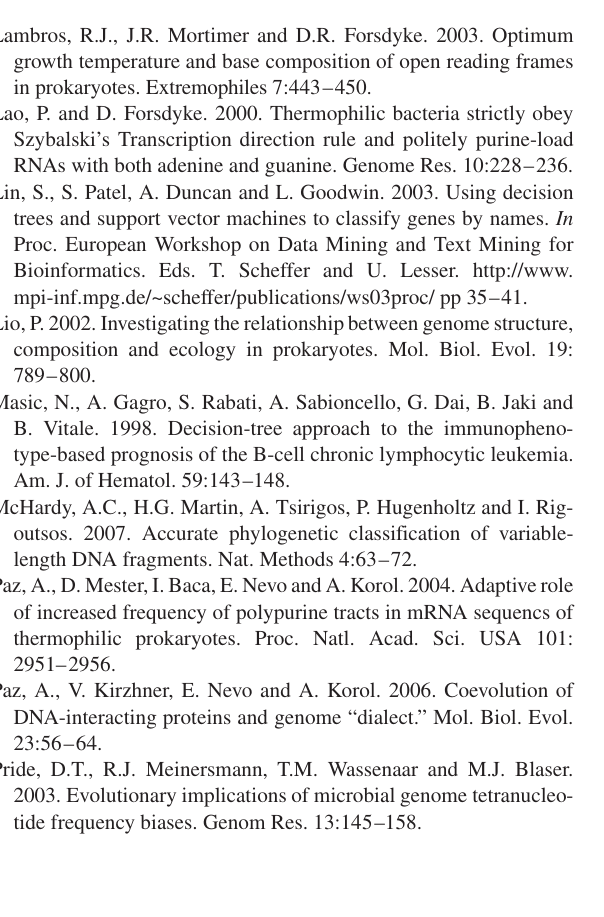
Supplementary Table S1. A list of the 195 organisms of which the genomes were used in this study (24 archaea and 171 bacteria). The complete genome sequences were downloaded from GenBank (http://www.ncbi.nlm.nih.gov/genomes/lproks.cgi) on April 1, 2006.